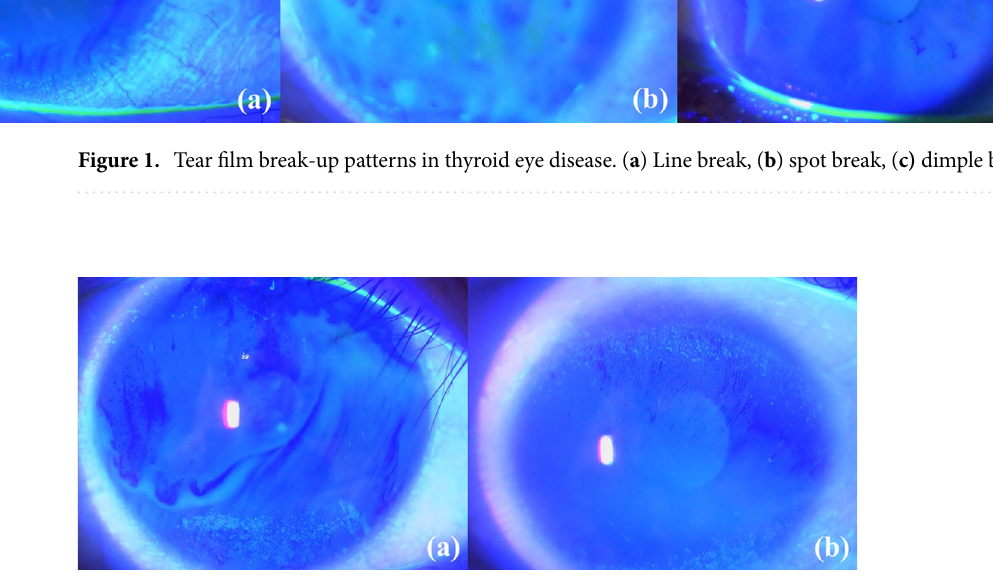
Figure 2. Random breaks in thyroid eye disease. Tear film break-up occurs simultaneously in the upper and lower parts of cornea ( a ) or occurs from the upper part of cornea ( b